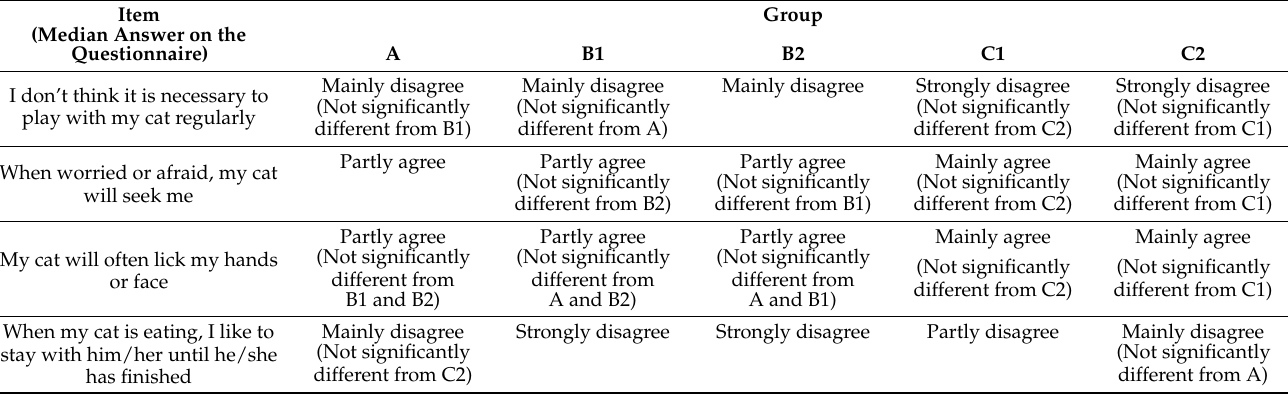
Table 3. Median rating on the items not loaded on any PC, in each of the groups. Note that contrasts between clusters are all significant, except where indicated.